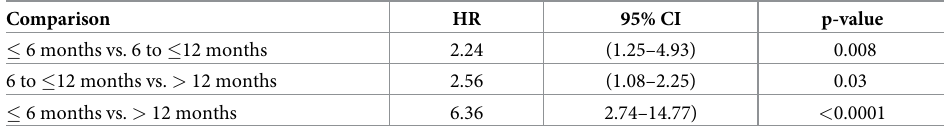
Table 3. Comparison of gonadectomy age groups and the risk for orthopedic injuries in a cohort of Golden Retrievers.